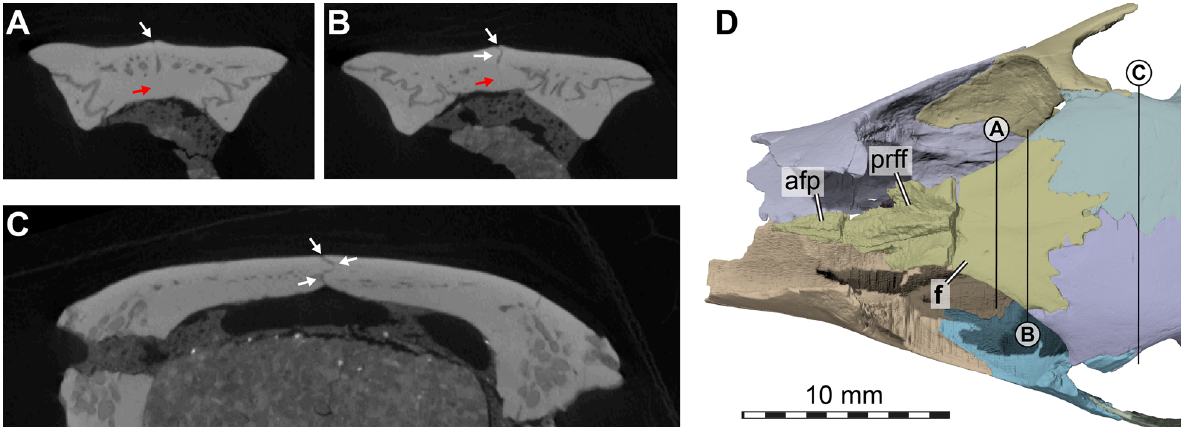
Fig. 6 Computed tomographs through the cranium of Plastomenus thomasii (AMNH FR 6015) and frontal morphology. A – C , cropped µCT slices through the frontal ( A – B ) and parietal ( C ) region of the skull roof. D Partial cranium in dorsal view, with prefrontals removed to illustrate the anterior frontal process. Note that bones are labelled in bold. White arrows show examples of traceable suture lines, red arrow indicates region in which an interfrontal suture would have been expected if the bones were not fused. Straight lines in D indicate slice positions for ( A – C ). apf anterior frontal process, f fused frontals, prff prefrontal facet on